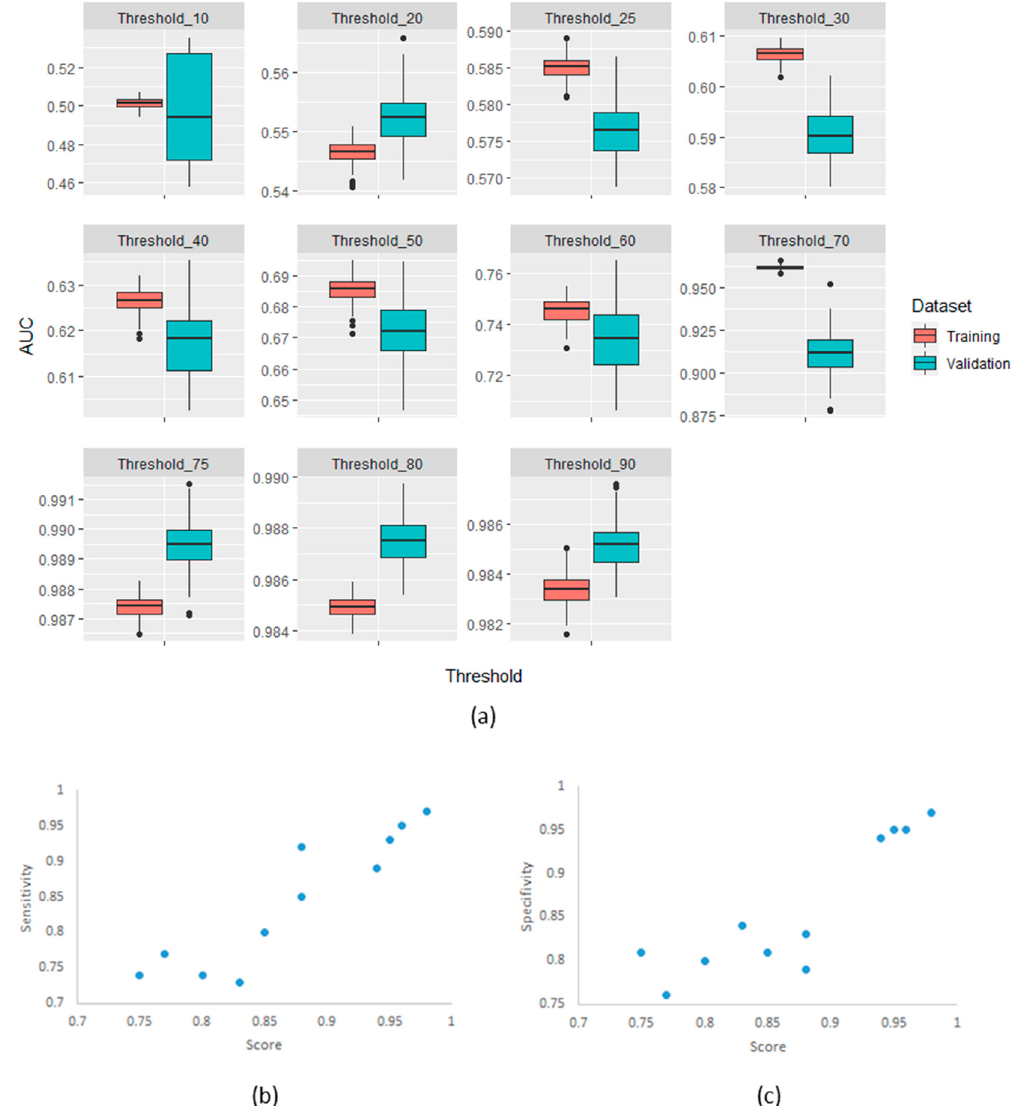
Figure 4. ( a ) AUC distributions across 100-runs for MaasPenn radiomics reproducibility score in the training and validation datasets for each of the thresholds of percentage reproducible HRFs; ( b ) The sensitivity as a function of the score and threshold; and ( c ) The specificity as a function of the score and threshold.